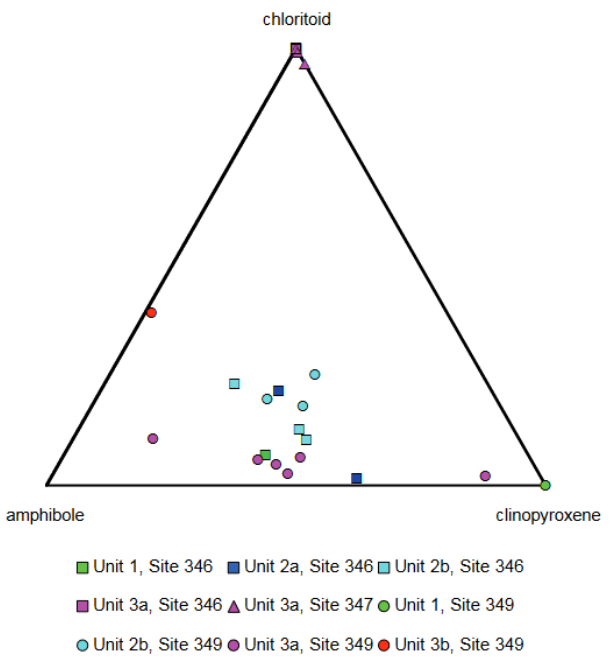
Figure 15. Ternary diagram demonstrating the convergence of heavy mineral assemblage composi- tions from the Early Oligocene (Unit 3a) to the Late Oligocene (Unit 2b) at the Jan Mayen Ridge sites.